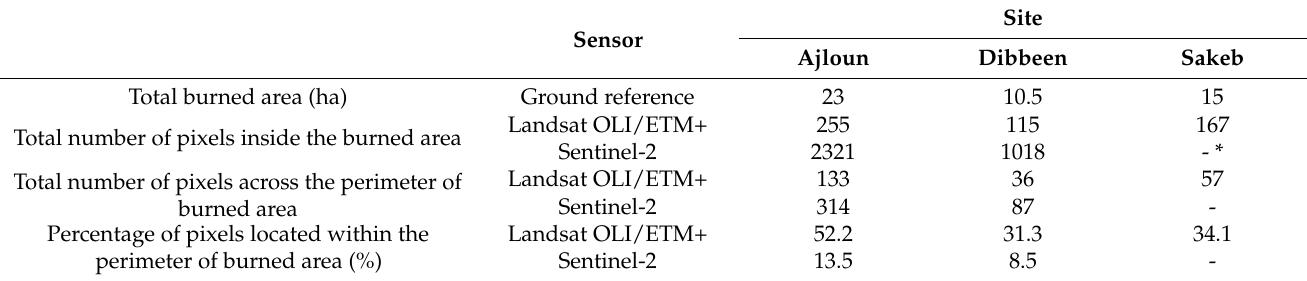
Table 3. Total burned area (ground reference data), total number of pixels inside and within the perimeter burned area in Ajloun, Dibbeen and Sakeb forest fires, Northern Jordan. Satellite sensor data were from Landsat OLI (Ajloun, Dibbeen)/ETM+ (Sakeb) and Sentinel-2 MSI (Ajloun and Dibbeen). Site Sensor Ajloun Dibbeen